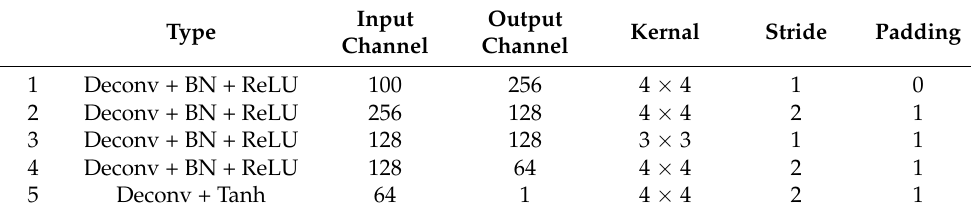
Table 2. The parameter configuration of the proposed model on submodule De